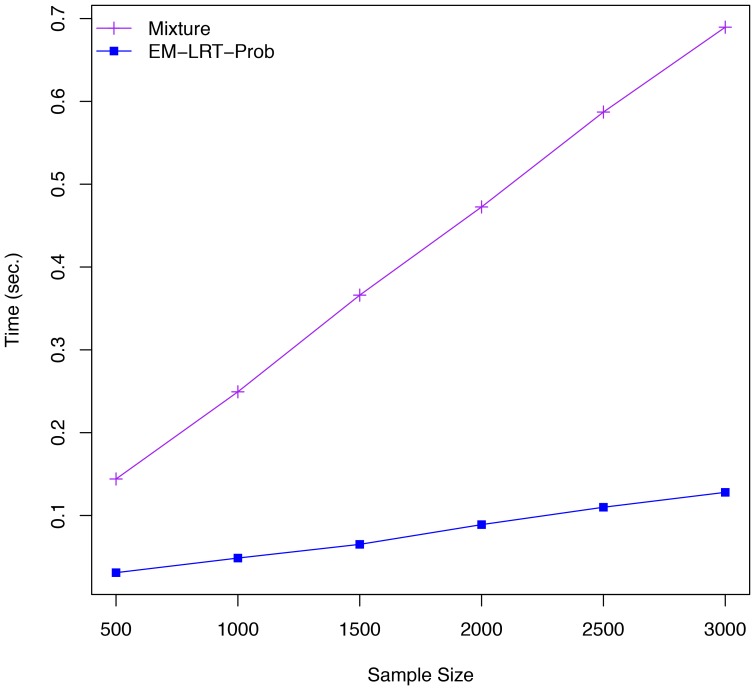
Computing Time: Mixture Method vs EM-LRT-Prob.The computing time of the Mixture method and our proposed EM-LRT-Prob method is displayed across a range of sample sizes. For each sample size, computing time is averaged across 2,000 simulated datasets.